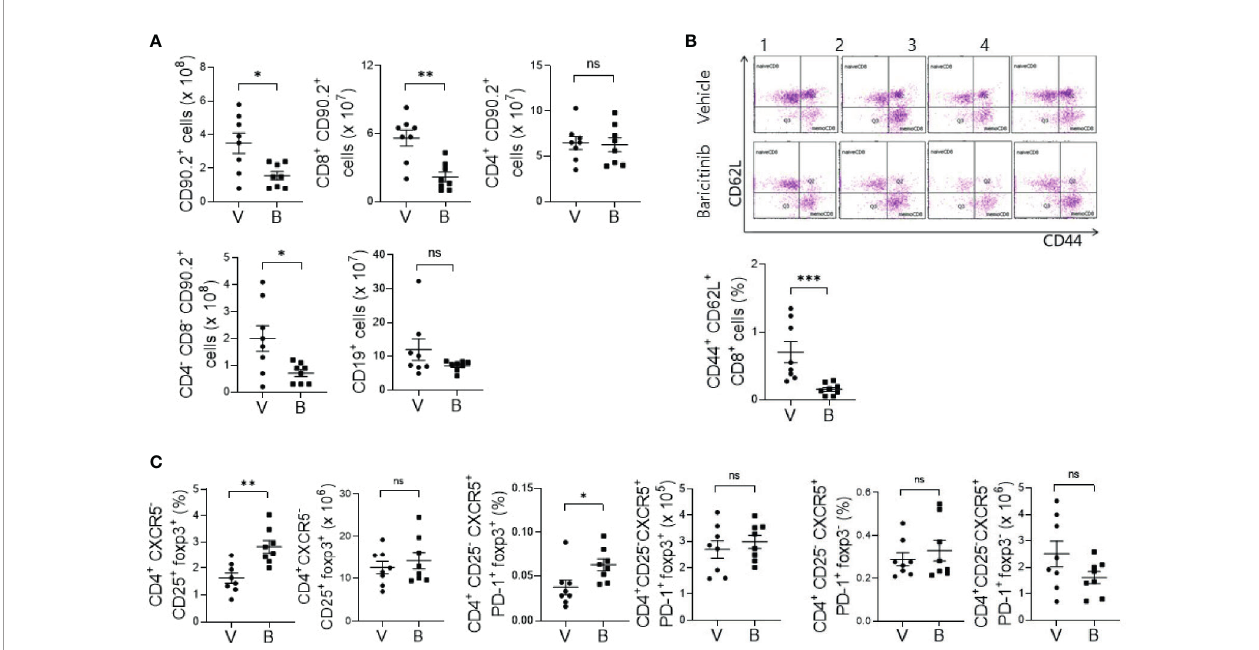
FIGURE 2 | Effects of in vivo treatment with baricitinib on subsets of T and B cells in spleens of MRL/ lpr mice at the age of 16 weeks. Subsets of T and B cells from each group of mice were determined using fl ow cytometry. (A) Absolute cell numbers of total T cells (CD90.2+ cells), CD8+ T cells, CD4+ T cells, double negative T (DNT) cells (CD4-CD8-CD90.2+ T cells), and total B cells (CD19+ cells) are shown. (B) Representative fl ow cytometric plots of central memory CD8+ T cells (CD44+ CD62L+CD8+ cells) are shown in the upper panel. The percentage of central memory CD8+ T cells among total T cells is shown in the lower panel. (C) The absolute numbers and percentages of CD4+CD25+CXCR5-FOXP3+ cells (Treg cells), CD4+CD25-CXCR5+PD-1+FOXP3+ cells (Tfr cells), and CD4+CD25-CXCR5+PD-1+ FOXP3- (Tfh cells) among total T cells are shown. Data are expressed as mean ± SD. * p < 0.05; ** p < 0.01; *** p < 0.001; ns, not signi fi